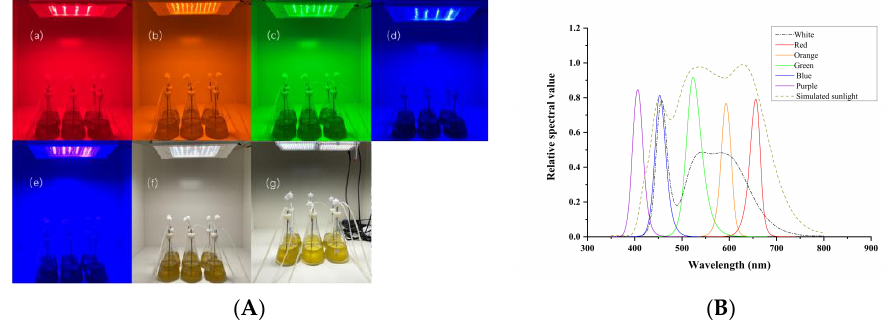
Figure 1. Cultures of I. zhanjiangensis under different LED sources ( A ) and the spectrum of different LED light sources ( B ). ( a ) red, ( b ) orange, ( c ) green, ( d , e ) purple, ( f ) simulated sunlight, ( g )